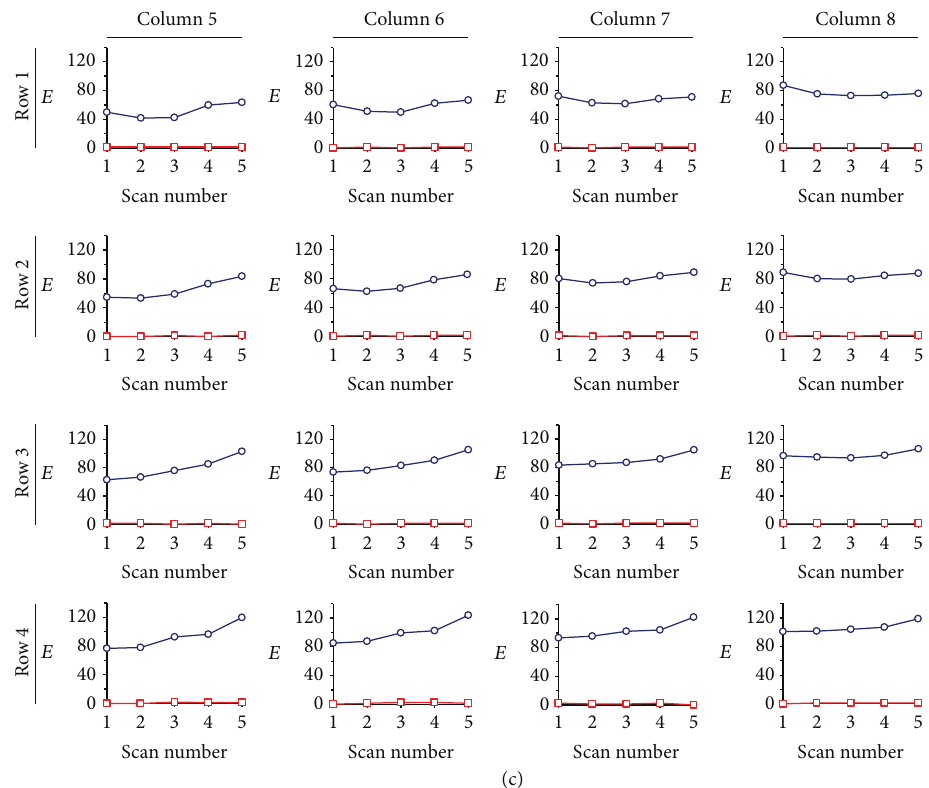
Figure 7: Positioning errors of chambers ( E ) during five times of scans. (a) Sequence of odd-number scan and even-number scan. (b) Image representation of errors for the chamber at row 3 and column 3. The arrow indicates the target location of alignment marks. With the position control, all alignment marks were maintained at the target locations. Scale bar: 250 𝜇 m. (c) E values of the 32 chambers during the 5 scans. Circles and squares represent the conditions without control and with position control,